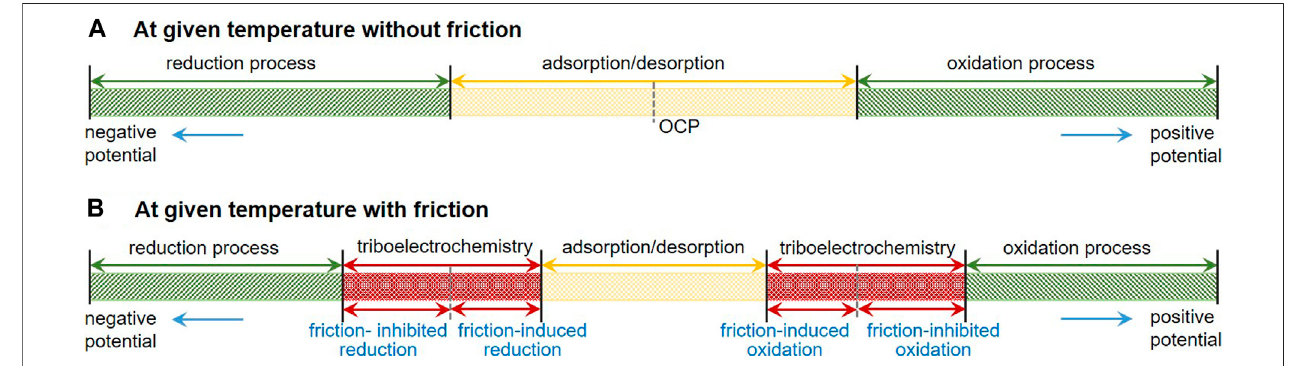
FIGURE 1 | Schematic diagram of the electrode processes at a given temperature without (A) and with (B) friction.